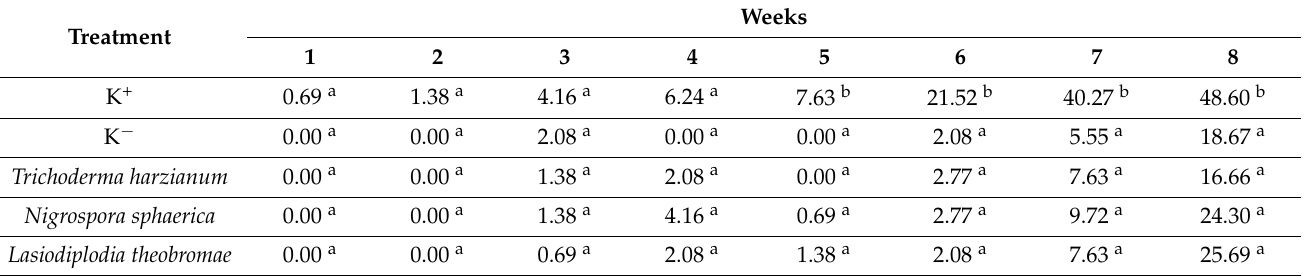
Table 4. Severity of Fusarium Wilt on Banana Leaf Plant 1–8 Weeks after Inoculation (%).